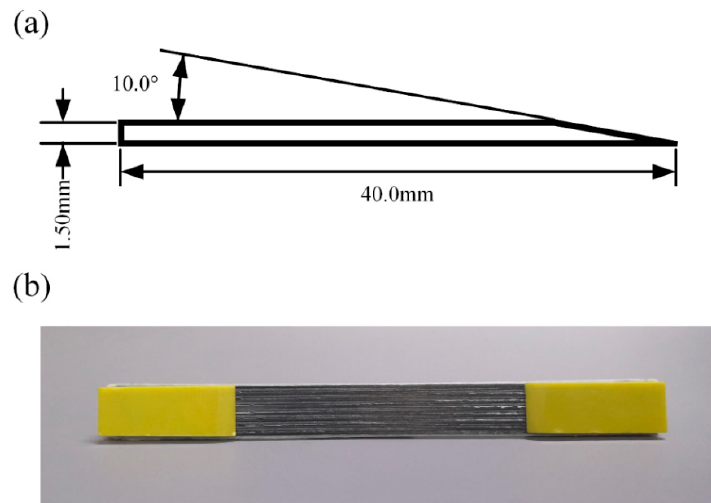
Figure 6. Clip size and final specimen. ( a ) Dimensions of clips; ( b ) Continuous carbon fiber-reinforced 3D printing tensile specimen.